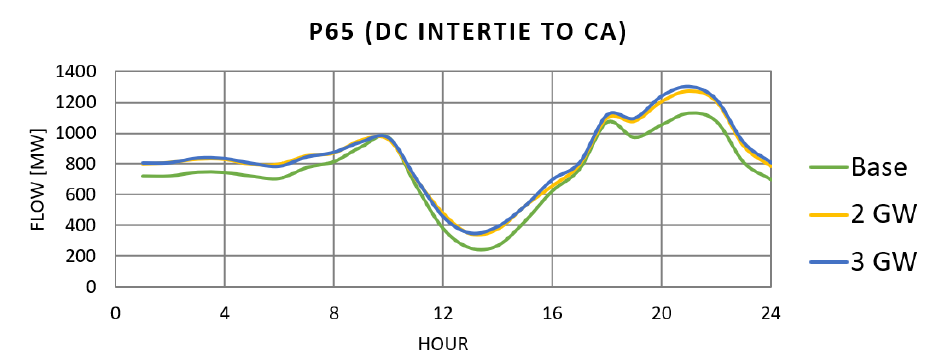
Figure 12. Impacts to daily hourly average flows for each hour of the year from OSW integration on Path 65, the transmission path from the Columbia River Gorge area into Southern California (DC intertie). Positive direction is flow south into